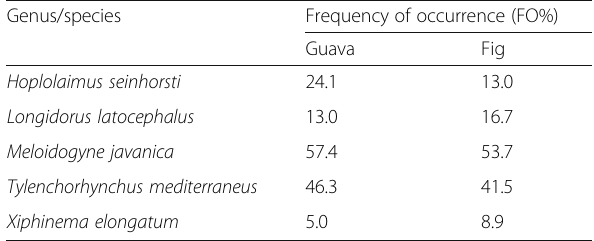
Table 1 Frequency of occurrence (FO%) of plant-parasitic nematodes associated with guava, Psidium guajava and fig, Ficus carica , at the beginning of the management experiments